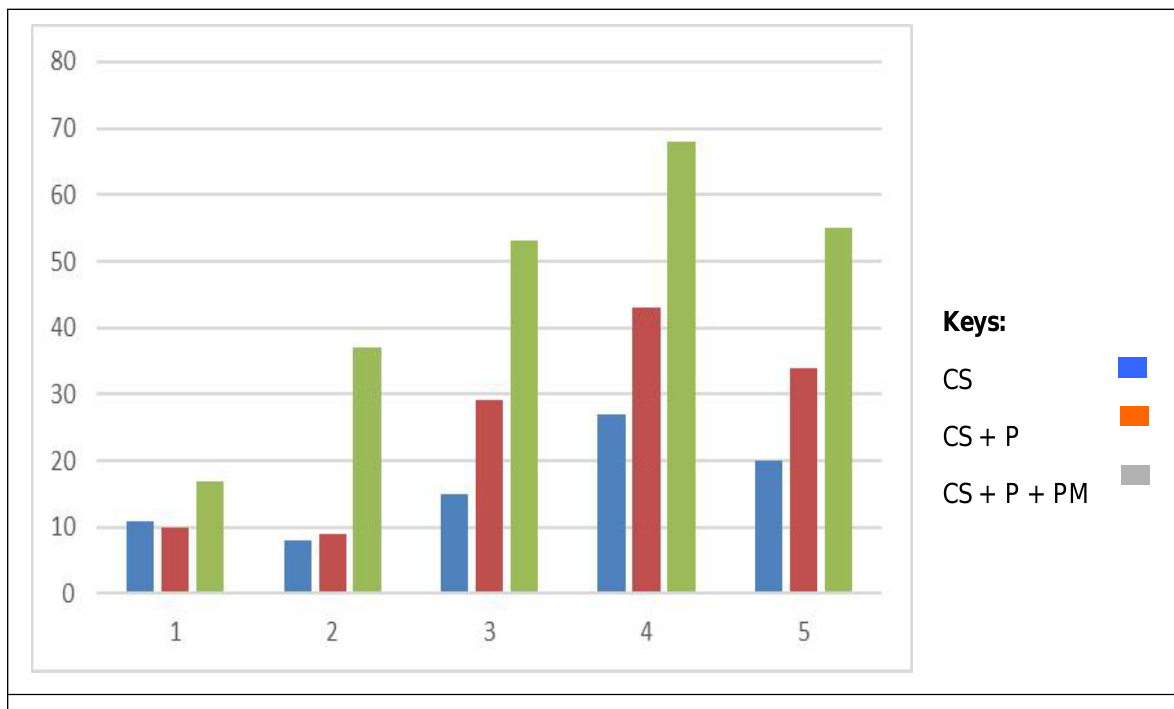
Figure 2: Counts of hydrocarbon utilizing bacteria in used motor oil polluted